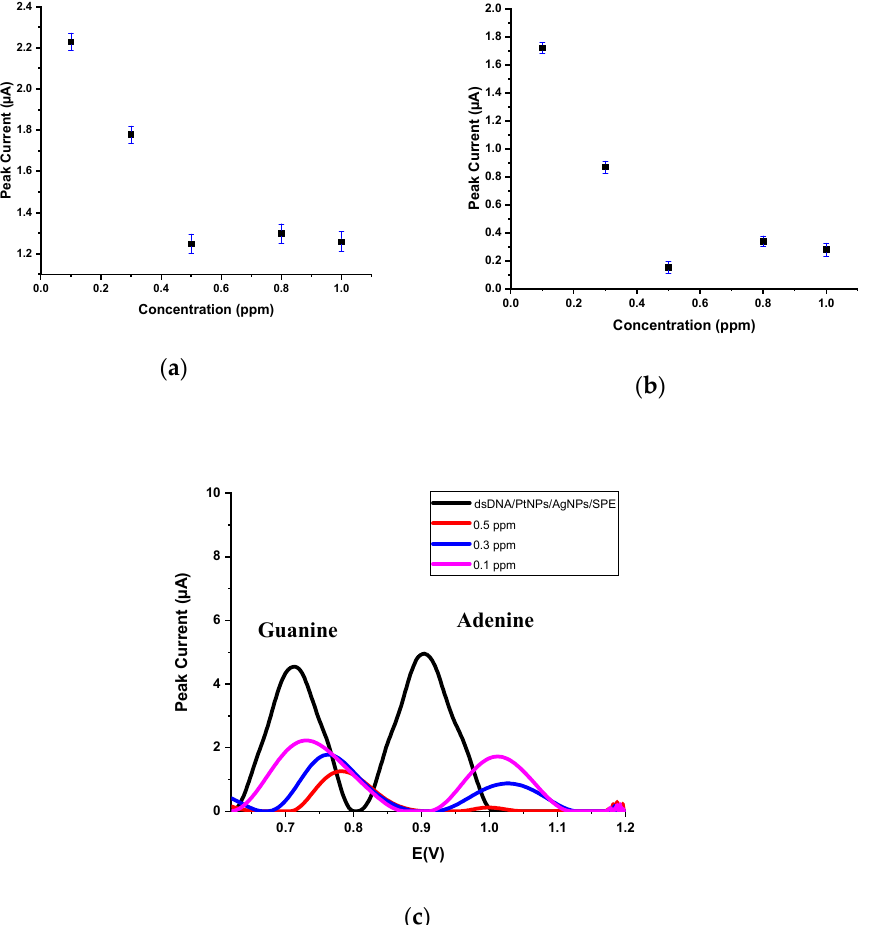
Figure 9. ( a ) The effect of DOX concentration on signal of ( a ) dGuo and ( b ) dAdo; and ( c ) DP voltammograms of dsDNA/PtNPs/AgNPs/SPE (dotted blue) with different DOX concentration in pH 4.70 AB; 0.1 ppm (red), 0.3 ppm (blue), 0.5 ppm (pink).